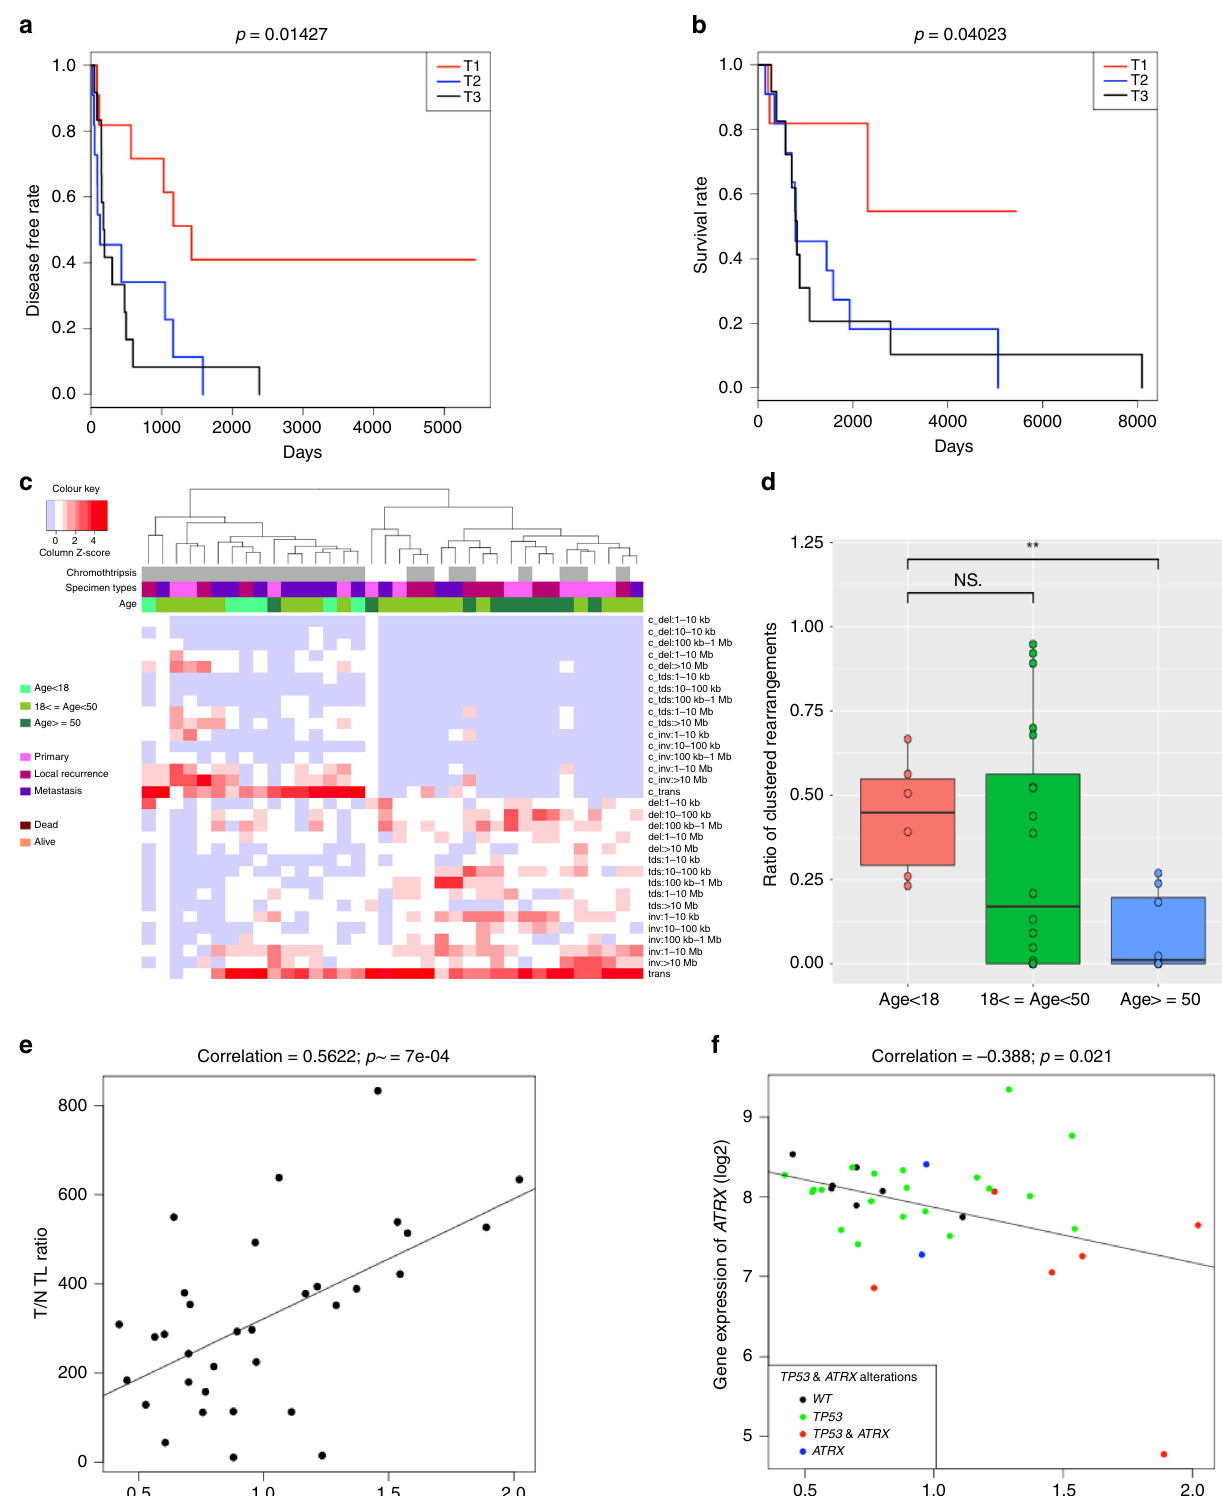
in DAXX had telomere lengths greater than the cohort median (Fig. 1f). Patient samples with the longest telomere length carried alterations in both TP53 and ATRX , supporting the permissive context in which TP53 alterations can allow for activation of alternative lengthening of telomeres (ALT) 18 . In addition, the expression levels of telomere maintenance genes HNRNPA2B1 ,